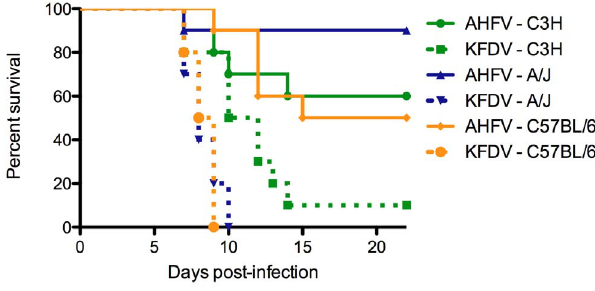
Figure 1. KFDV is more virulent than AHFV in 3 immunocom- petent mouse strains. C3H, A/J and C57BL/6J mice were inoculated subcutaneously with either 1 6 10 5 TCID 50 AHFV or 1 6 10 5 TCID 50 KFDV (n=10/group) and monitored for 28 days. Regardless of strain, KFDV infection resulted in higher mortality and more severe disease than